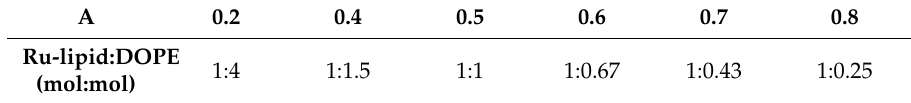
Table 1. Liposome composition (mole ratio). Ru-lipid: RuC11C11 or